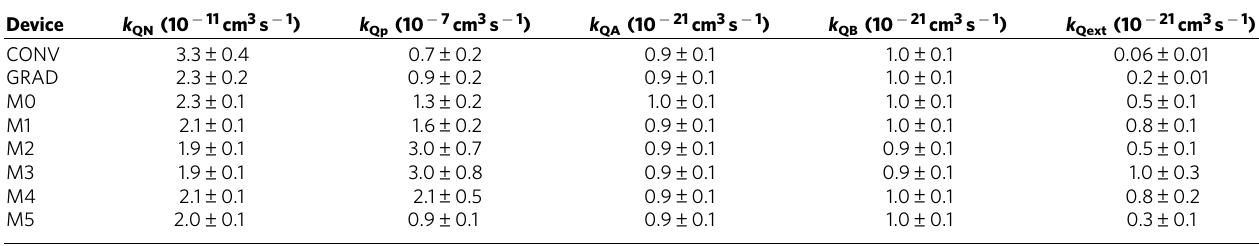
Table 2 | Model parameters for the lifetime model for CONV, GRAD and managed PHOLEDs. Device k QN (10 (cid:2) 11 cm 3 s (cid:2) 1